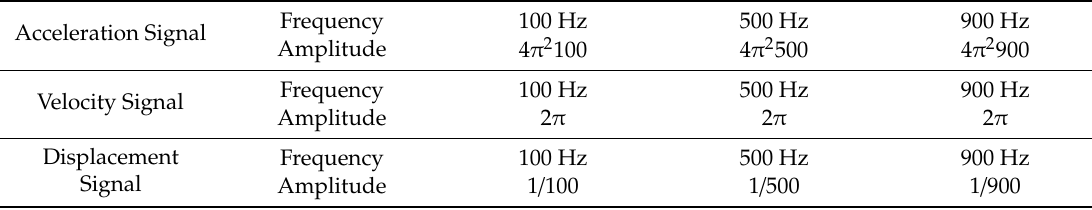
Table 1. The amplitude of each sinusoidal component in the three types of